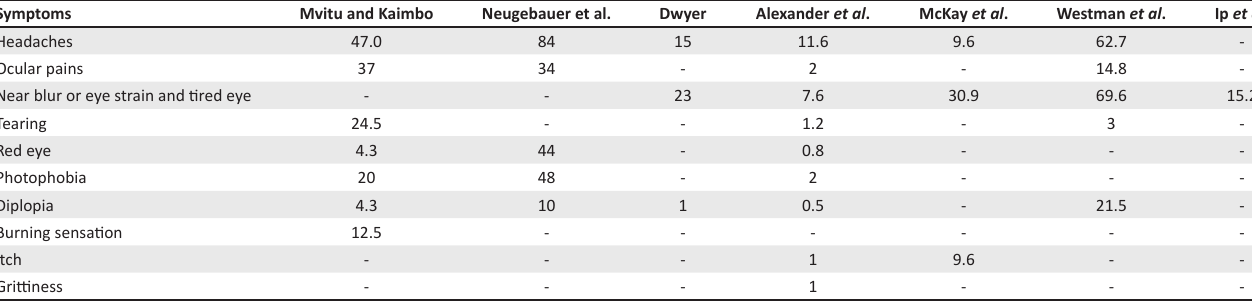
TABLE 1: Frequency (as percentage) of symptoms from various studies.